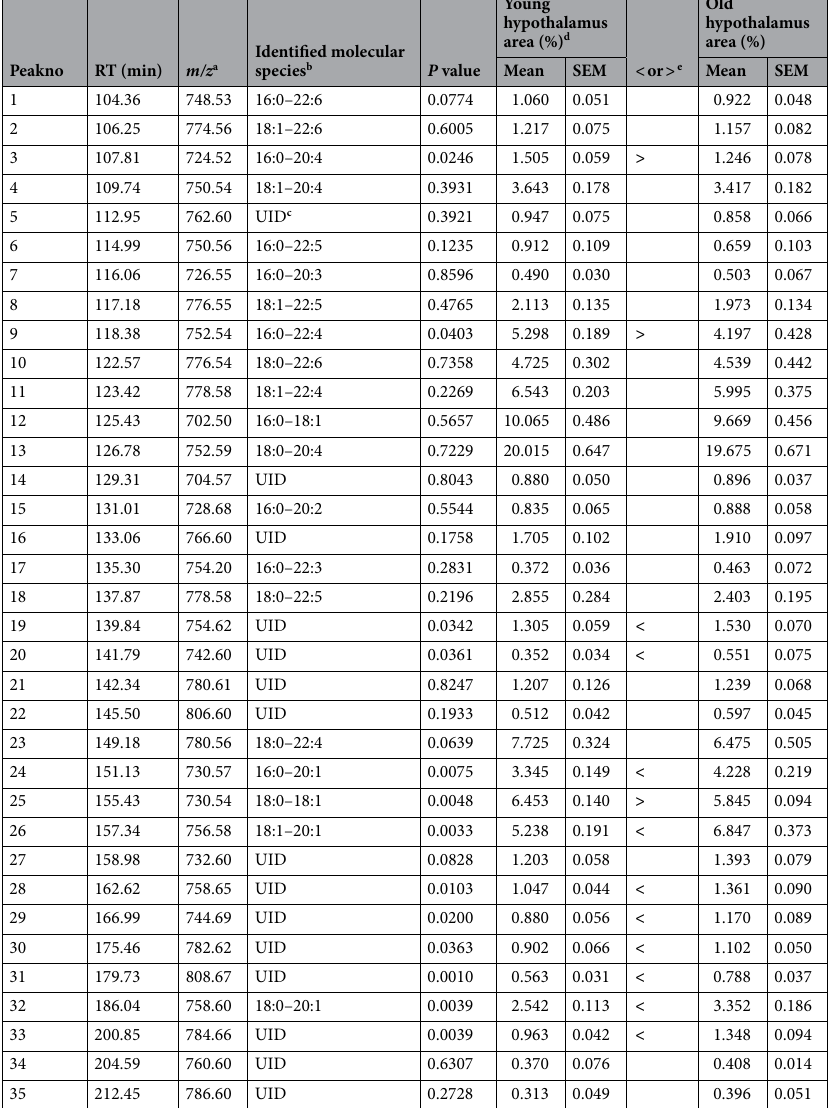
Table 2. Composition and comparison of hypothalamic EPl molecular species extracted from young (n = 6) and old (n = 6) brains. EPl ethanolamine plasmalogen, SEM standard error of the mean, RT retention time. a m/z : mass to charge ratio, identified as the molecular ion [M + H] + b Identified molecular species: denoted as the carbon chains at the sn-1 position and fatty acids at the sn-2 position. c Molecular species not identified. d Ratio of the peak area of each EPl molecular species to the total peak area. e The ratio was higher ( >) or lower ( <) in the hypothalami of young brains than in the corresponding of old brains. Statistical analysis was conducted using two-tailed unpaired t -tests. A blue or magenta background indicates a lower or higher ratio, respectively, in old than in young